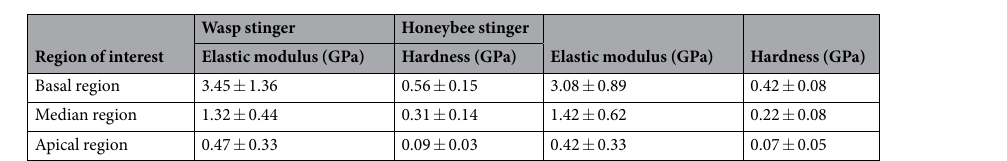
Table 1. A summary of quasi-static nanoindentation results of wasp and honeybee